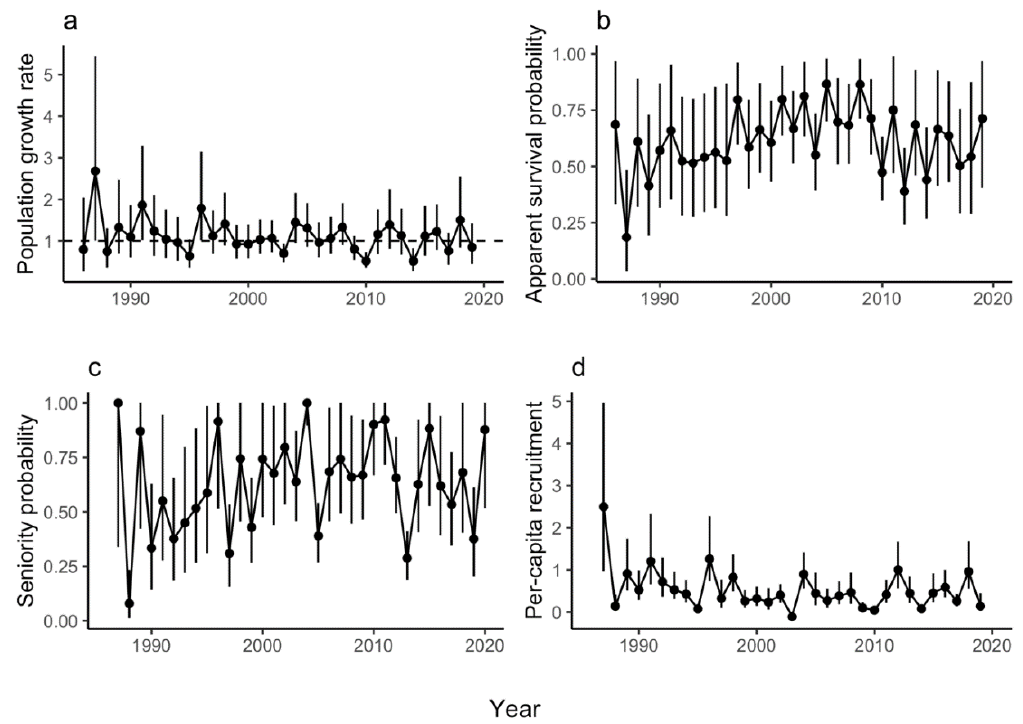
Figure 2. Lily Pond: Annual estimates and 95% credible intervals (vertical lines) of ( a ) population growth rate (ρ) where the horizontal dashed line represents a stable population (i.e., growth rate of one), ( b ) survival probability (φ), ( c ) seniority probability (γ), and ( d ) per-capita recruitment. Diversity 2020 , 12 , x FOR PEER REVIEW